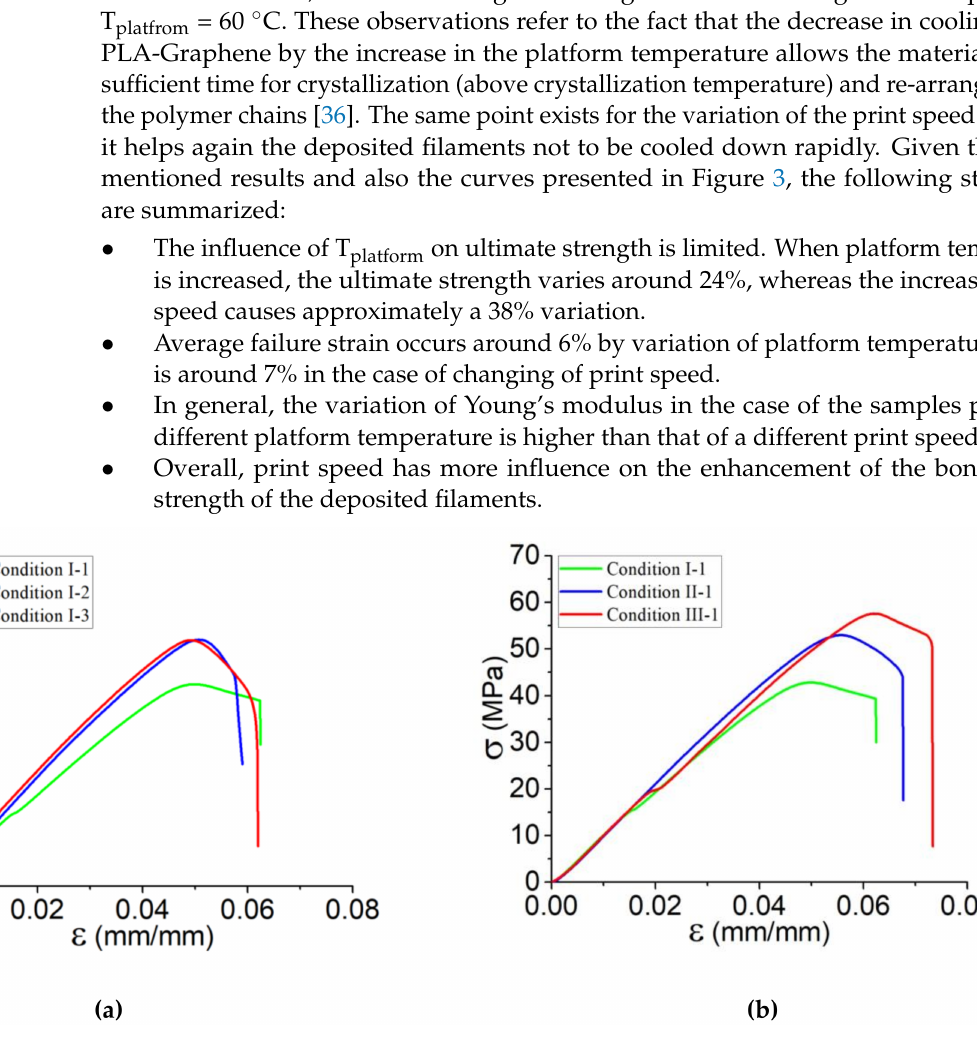
Figure 3. Tensile behavior for the set of samples cut from the printed solid blocks according to ( a ) conditions I-1, I-2, and I-3, representing the variation of platform temperature and ( b ) conditions I-1, II-1, and III-1, representing the variation of print